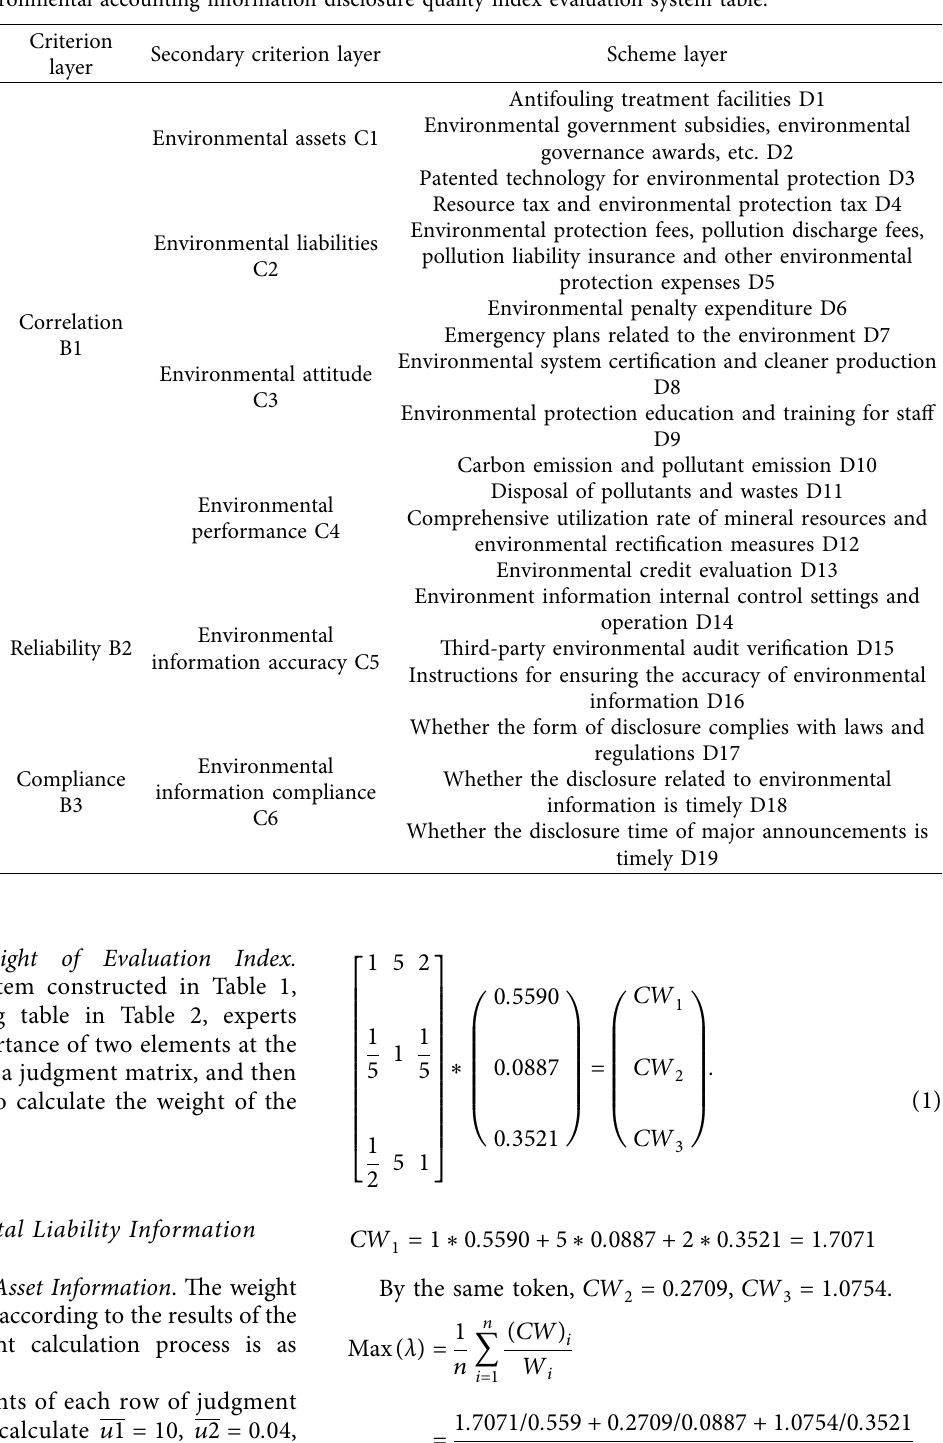
Table 1: Environmental accounting information disclosure quality index evaluation system